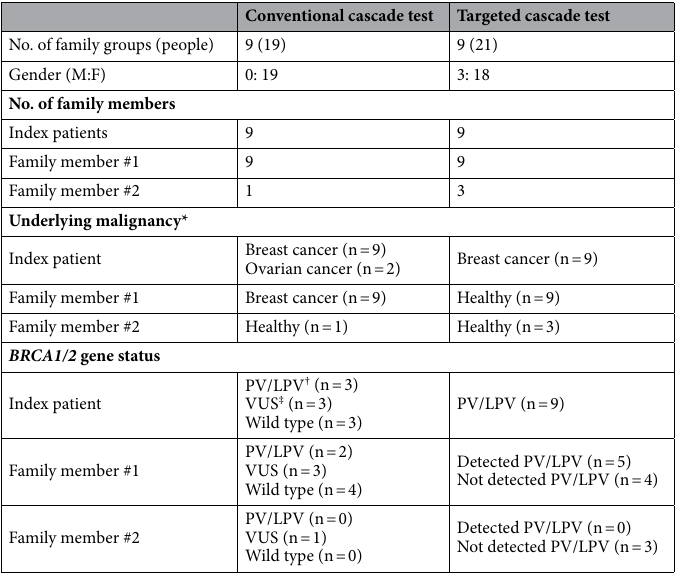
Table 1. Demographics of 18 family groups who underwent conventional and targeted cascade testing for BRCA1/2 genes. Underlying diseases could be duplicated; † PV/LPV pathogenic variant/likely pathogenic variant; ‡ VUS variant of uncertain